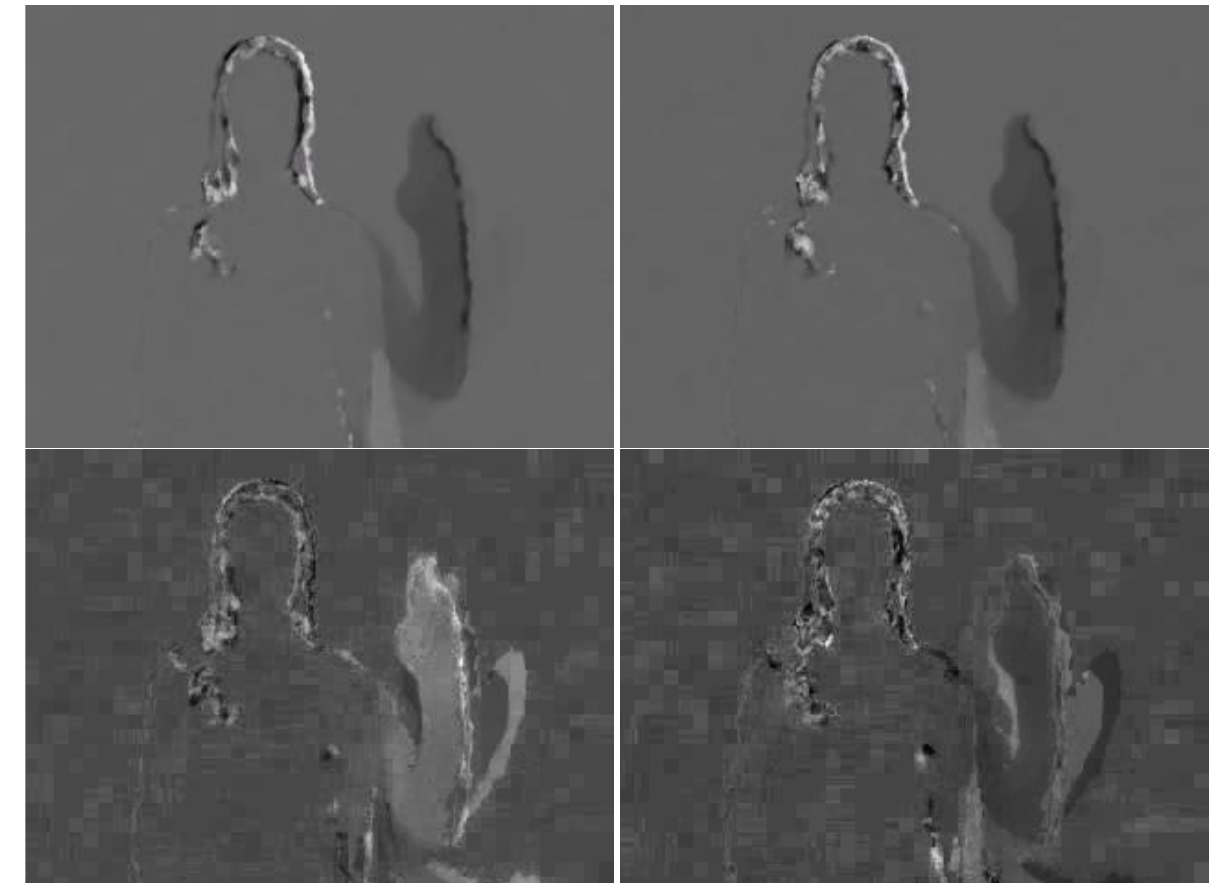
Figure 8. Samples of generated forward and backward Depth Dynamic Images (DDIs) and Depth Motion Dynamic Images (DMDIs) for gesture Mudra1/Ardhapataka, the left images are dynamic images for forward, the right images are dynamic images. From top to bottom: DDIs and